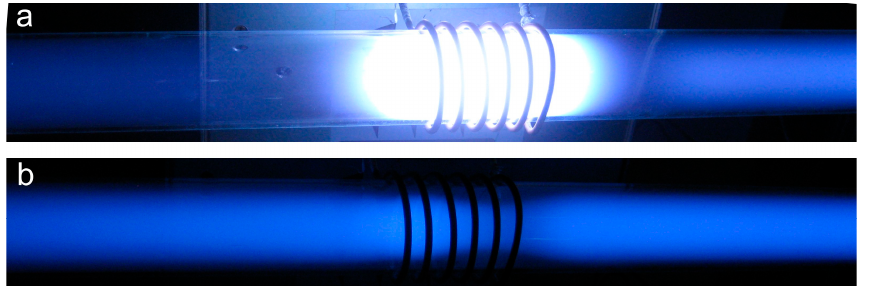
Figure 3. Photos of inductively coupled RF discharge in two distinguished modes: ( a ) H-mode (almost pure inductive character of the impedance) and ( b ) E-mode (with predominant capacitive component).